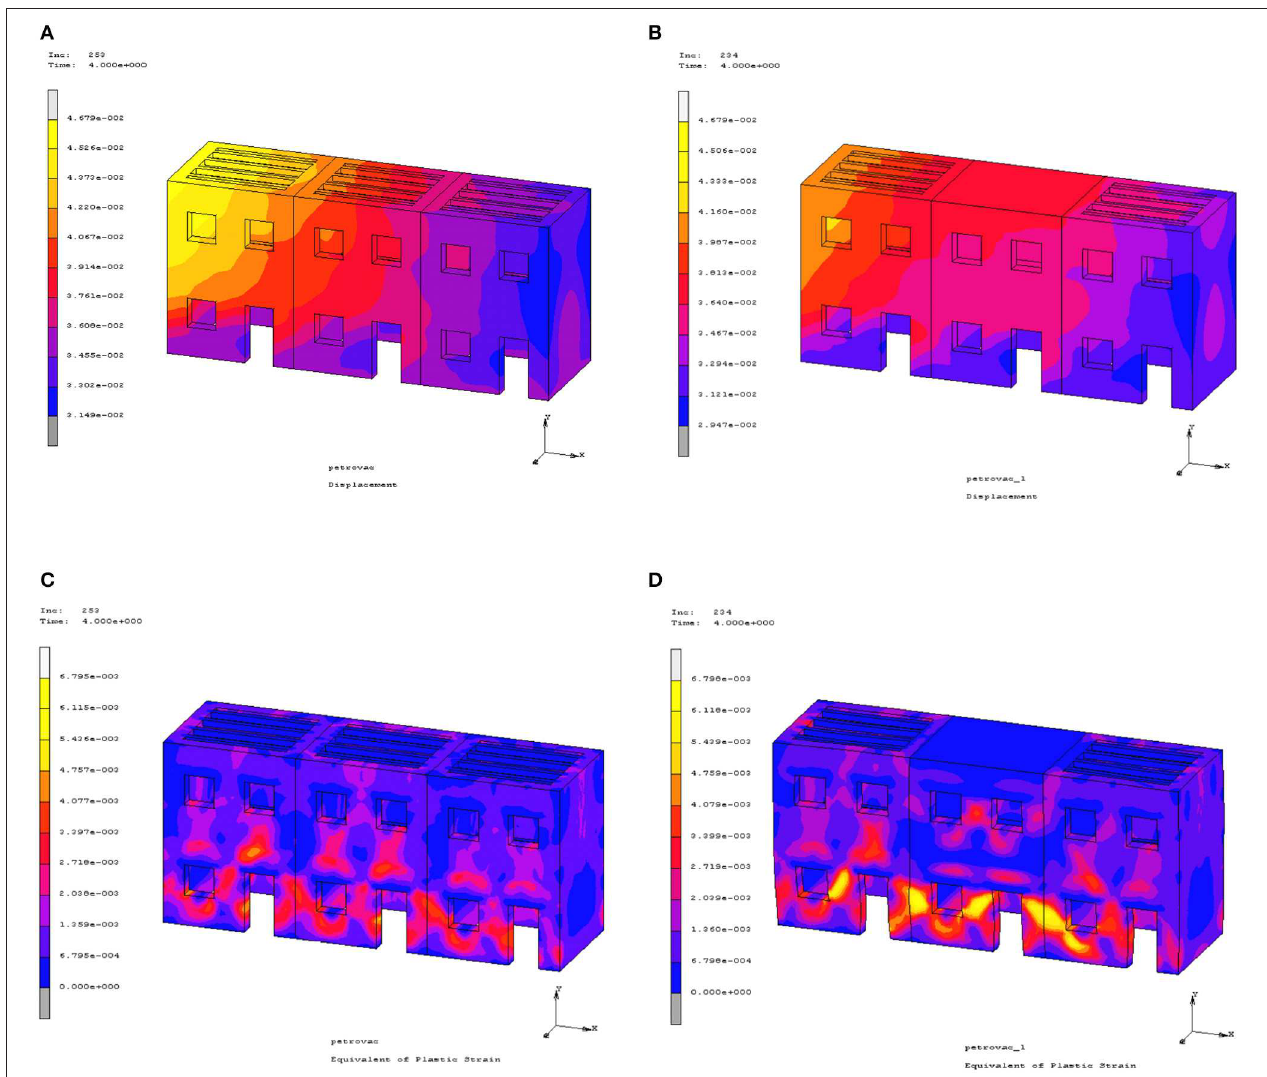
FIGURE 12 | Displacements (in m) of models (A) M1-M1-M1 and (B) M1-M2-M1 and equivalent plastic strains of models, (C) M1-M1-M1 and (D) M1-M2-M1, at 4s.